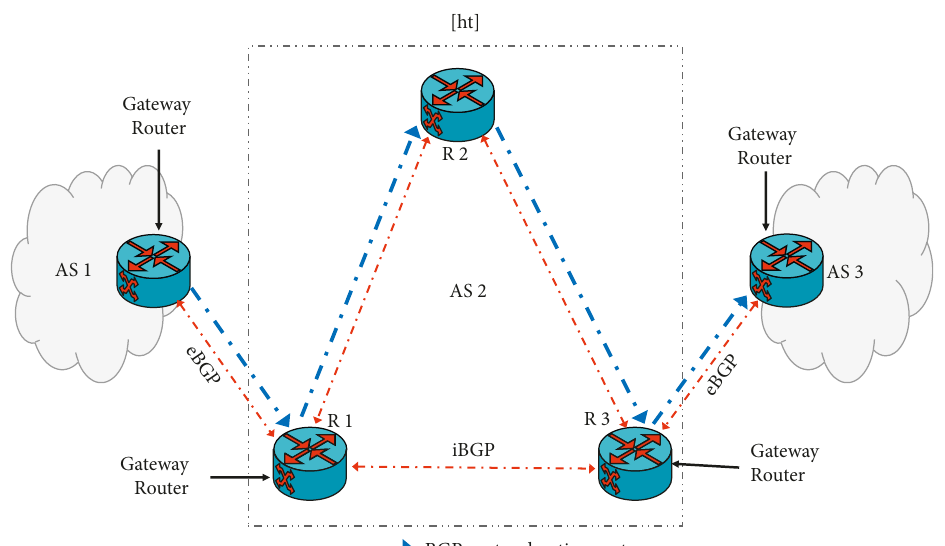
Figure 2: eBGP route advertisement